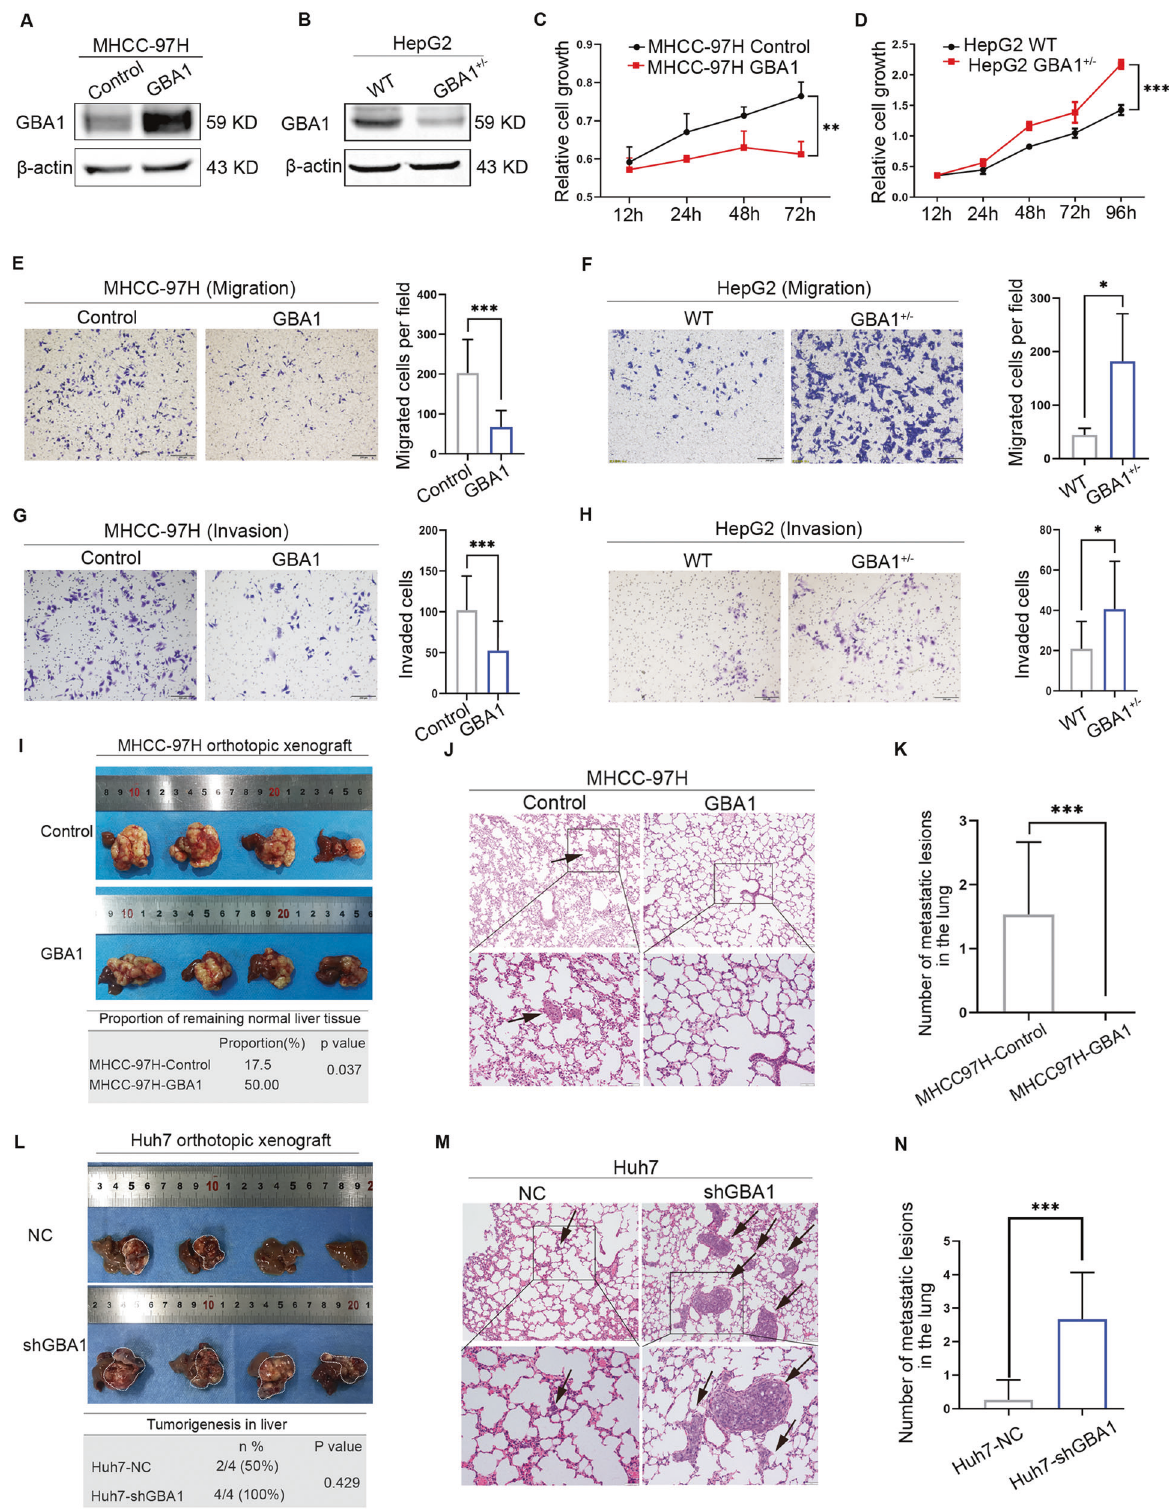
lungs were collected. Then, the tumour volume, the proportion of normal liver tissues, and the number of metastatic lesions in the lung were analysed. The results showed that overexpression of GBA1 appeared to reduce tumour growth, but no signi fi cant difference in tumour volume was observed between the two